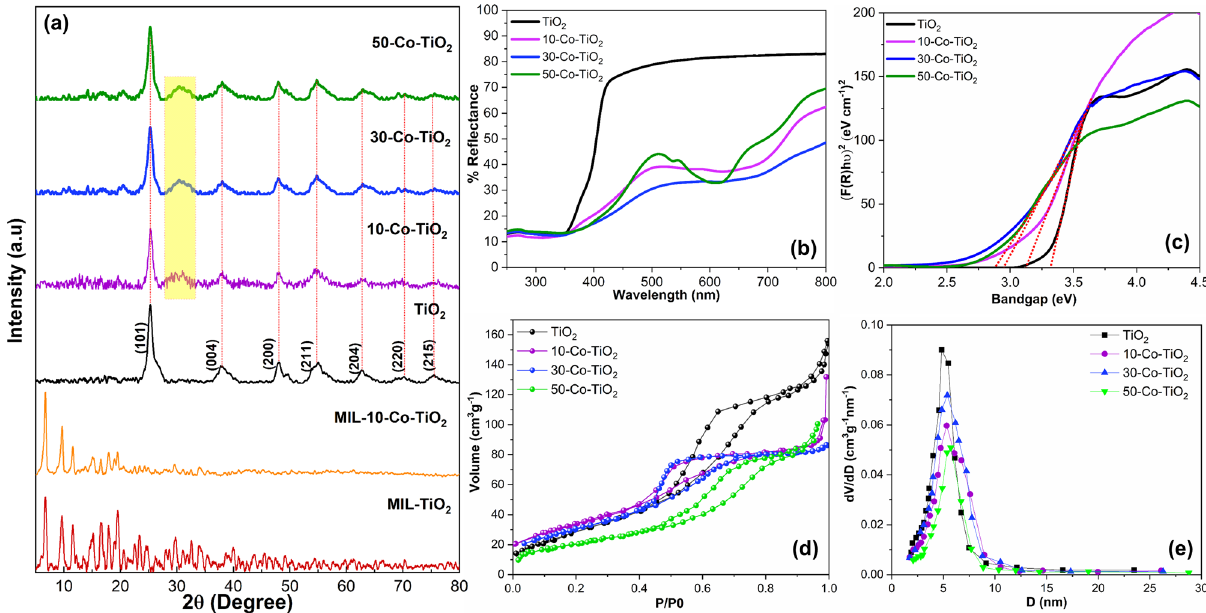
Figure 1. ( a ) PXRD patterns of pristine and doped MIL-125 (Ti) and the corresponding TiO 2 semiconductor oxides after thermal annealing. ( b ) Diffuse reflectance spectra of MOF derived TiO 2 samples and ( c ) its corresponding bandgap energy Kubelka–Munk plot ( d ) Nitrogen adsorption–desorption isotherms and ( e ) the corresponding BJH pore size